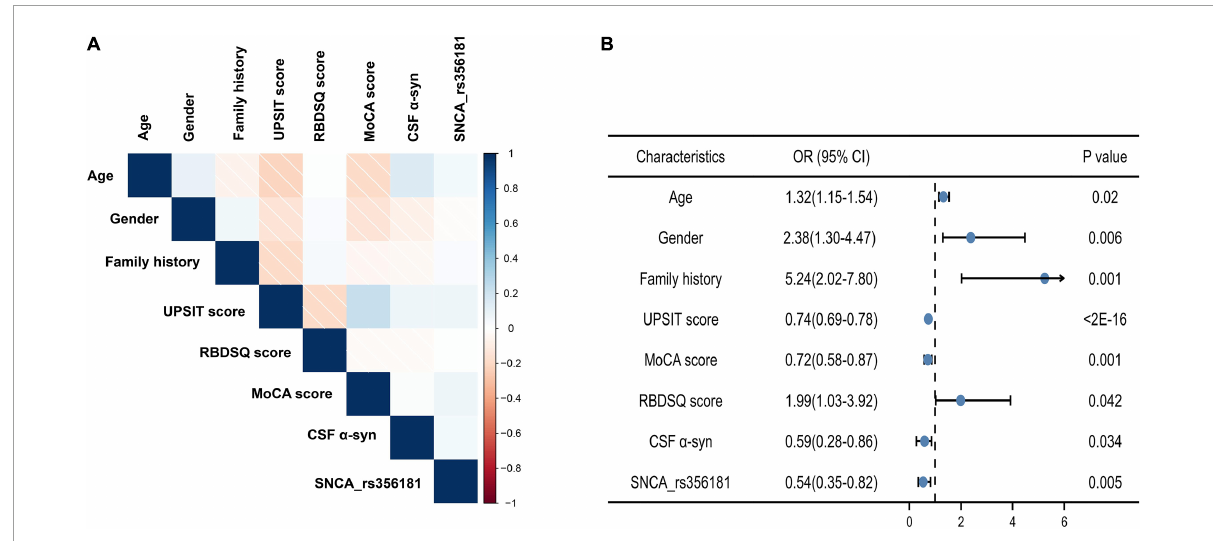
FIGURE3 The eight predictors in the final diagnostic model. (A) Correlation heatmap between the eight variables; (B) multivariate analysis of eight variables in the diagnostic model. MoCA, Montreal Cognitive Assessment; UPSIT, University of Pennsylvania Smell Inventory Test; RBM, Rapid-eye-movement sleep Behavior Disorder Screening Questionnaire; CSF α -syn, cerebrospinal fluid α